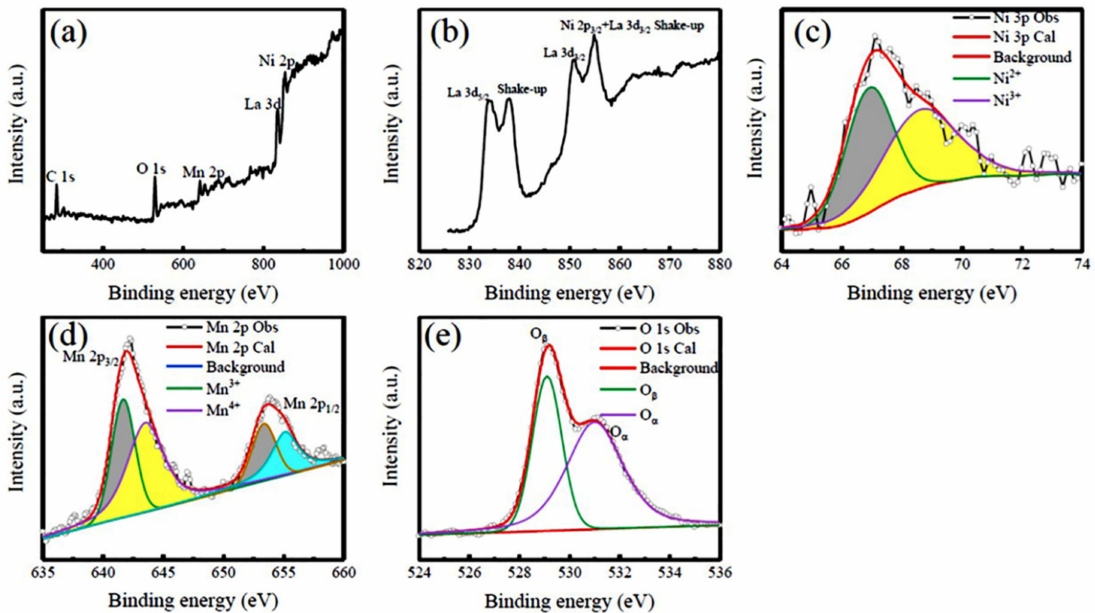
Figure 3. XPS spectra and peaking fitting of the LNMO NPs. ( a ) Survey scan XPS spectrum, ( b ) La 3d and Ni 2p, ( c ) Ni 3p, ( d ) Mn 2p, and ( e ) O1s XPS spectra.